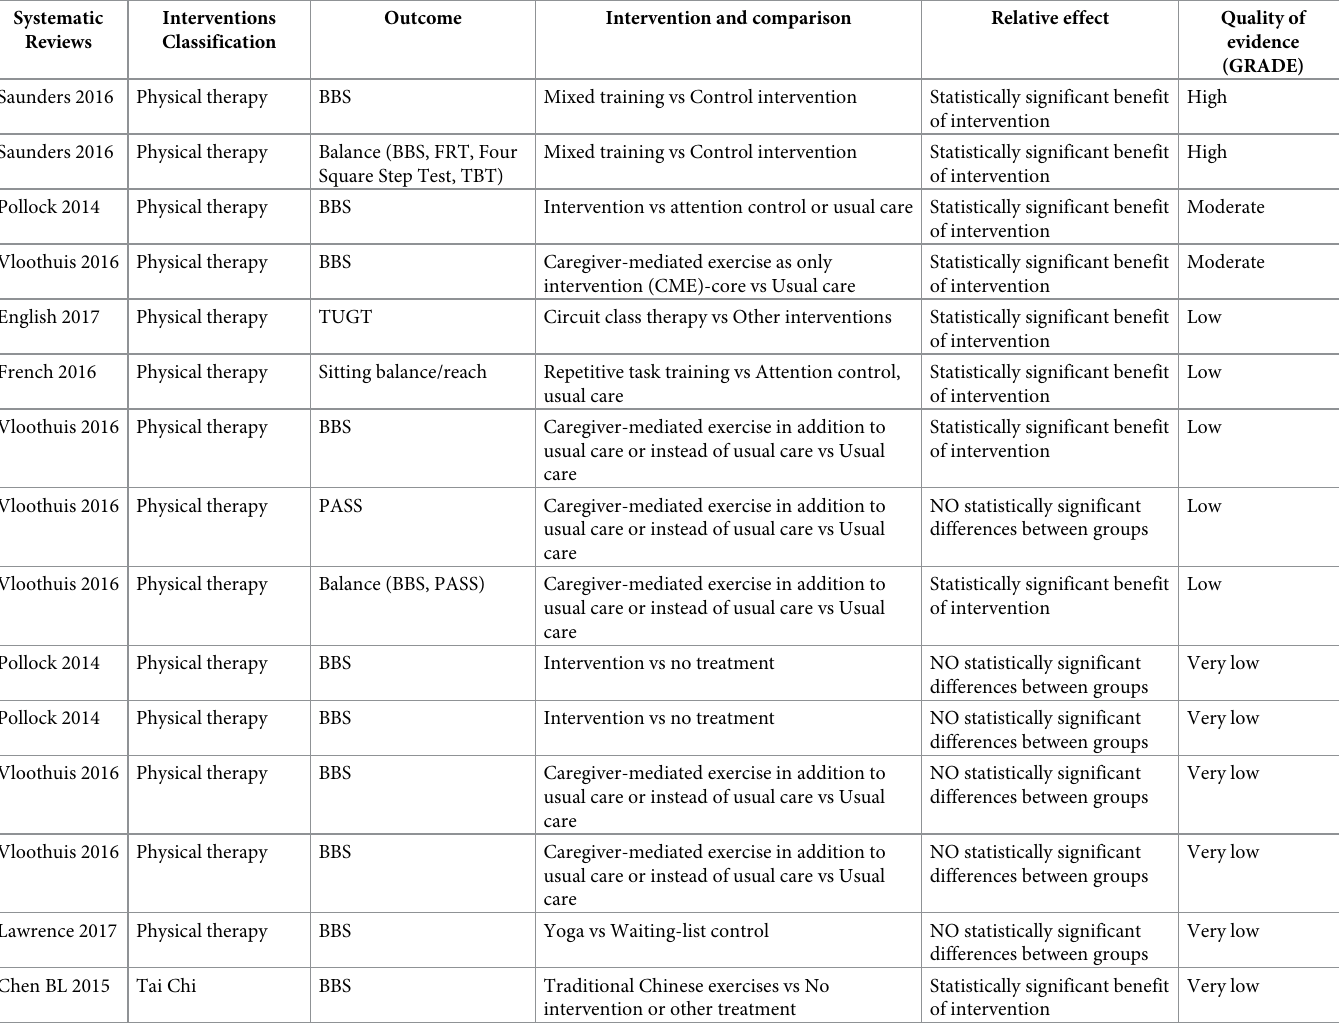
Table 3. Effectiveness of rehabilitation interventions on